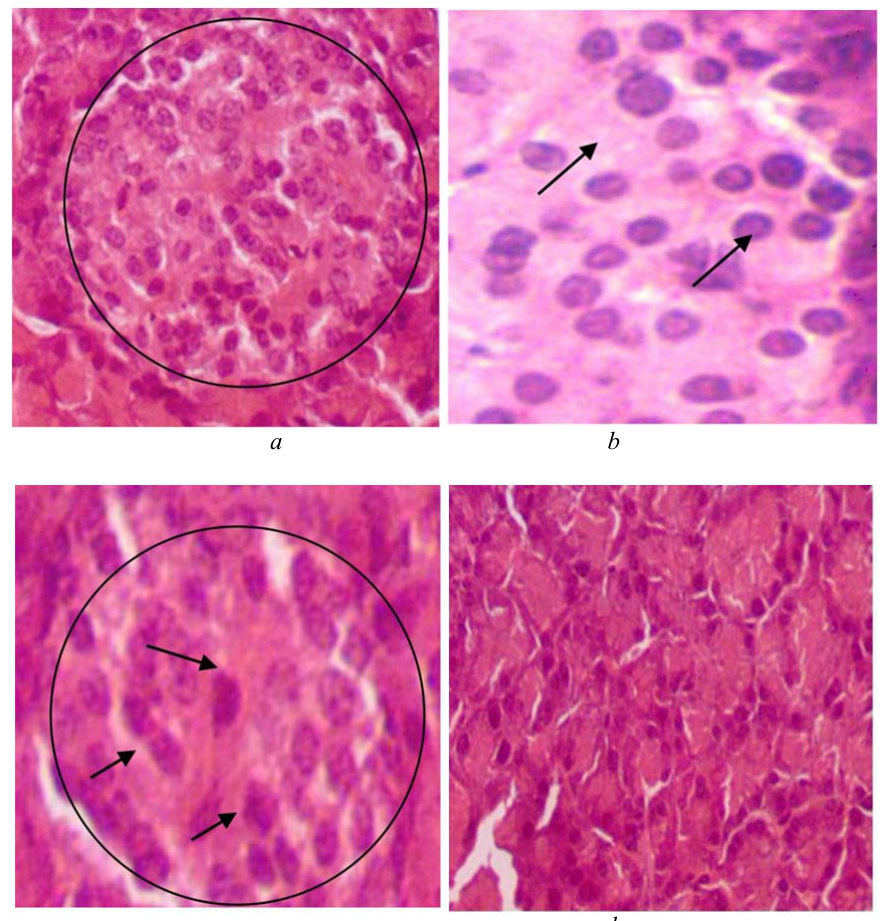
Fig. 5. The pancreas of Syrian hamsters, who received methformin on a background of fat-rich and fructose diets: a – less pronounced dilution of cells in a pancreatic islet, the absence of "levelling" the differential differences between the nuclei of endocrinocytes; b – a decrease in the presence of hypertrophic β -cells; c – in - the morphology of β -cells is close to normal; d – absence of cell vacuolization. Hematoxylin-eosin; a – ×250; b, c – ×400; d –